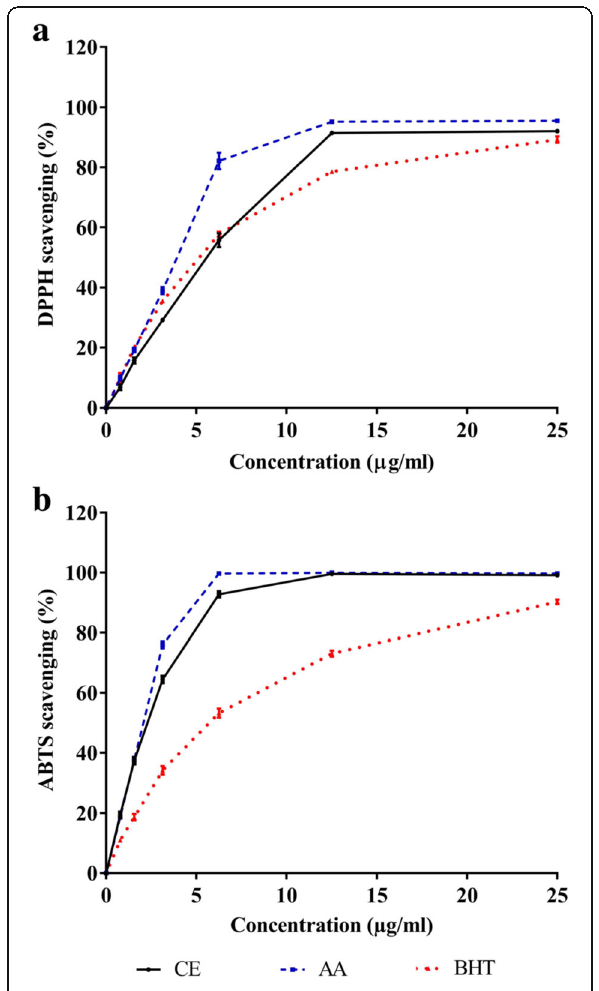
Fig. 1 Antioxidant activity of C. cainito extract. Panel a and b are the results from DPPH and ABTS) radical scavenging methods, respectively. The values are expressed as mean ± SEM, n = 3. AA: ascorbic acid; BHT: butylated hydroxytoluene; CE: C. cainito extract